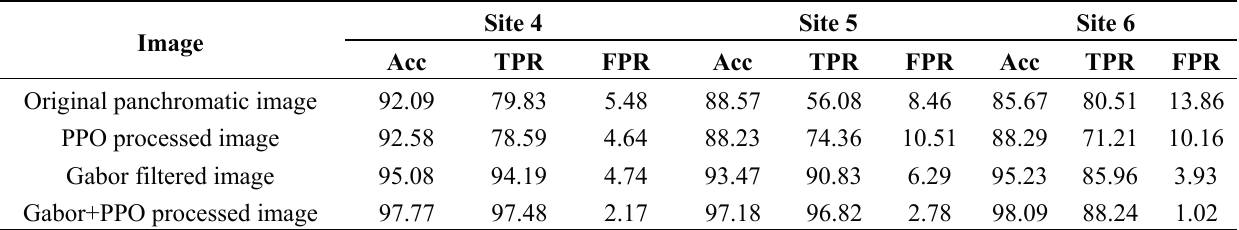
Table 2. Performance evaluation of the classification images when one global threshold (value: mean + 0.5 std) is applied to the original panchromatic image, the PPO processed image, the Gabor filtered image, and the Gabor + PPO processed (the proposed method) image, compared with the manual digitization for Sites 4–6 in the Greenland Ice Sheet